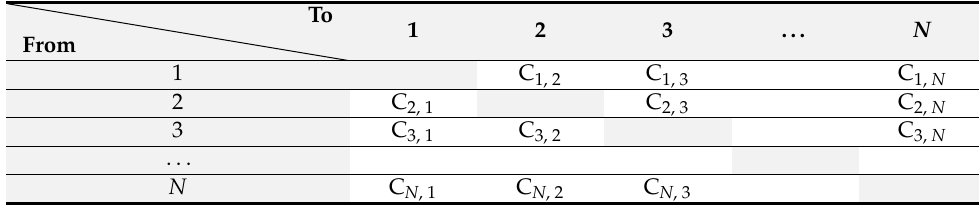
Table 1. Example of a Cost Matrix.